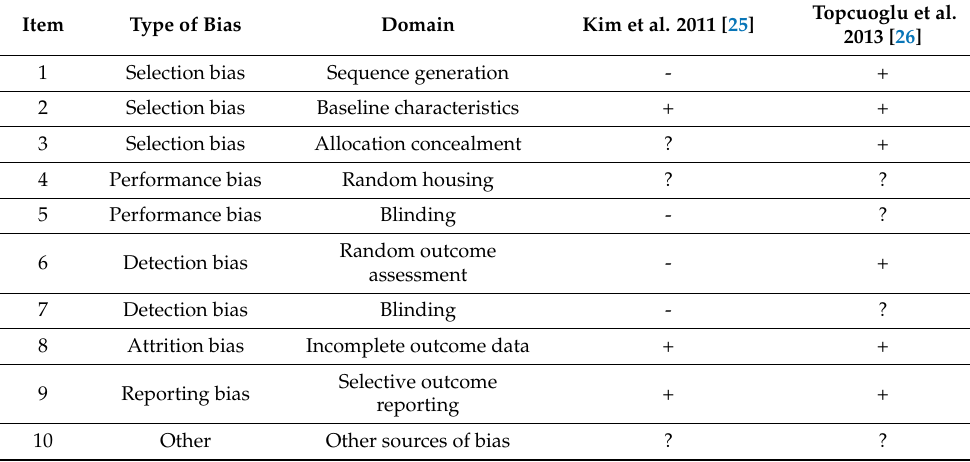
Table 2. Quality assessment according to SYRCLE Risk Assessment Tool.